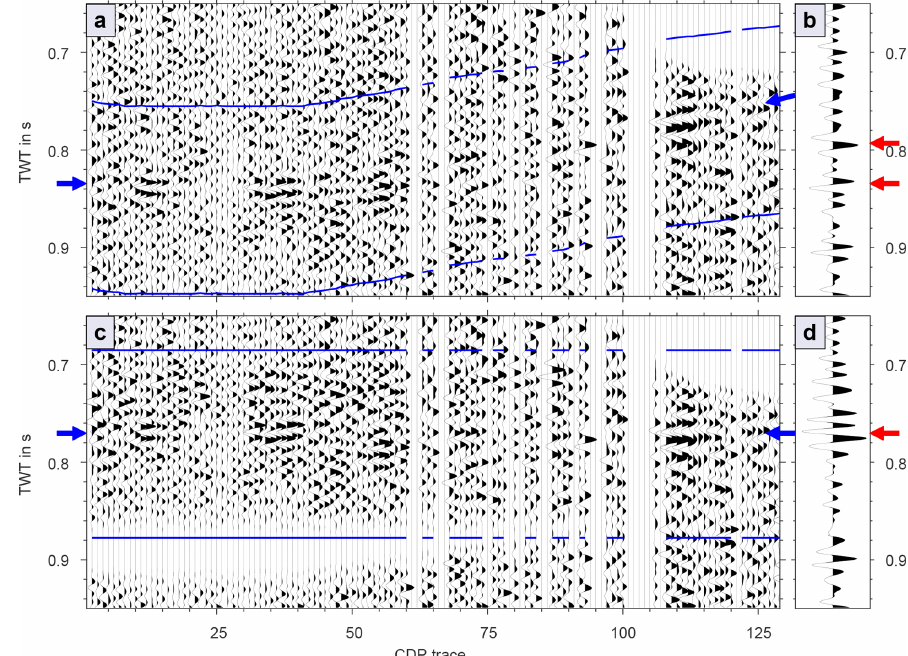
Figure 12. Cross-dip correction of an NMO-corrected reflection in CDP 926 of the Burträsk data. In the uncorrected CDP gather (a) , the reflection is approximately flat in the first traces and inclined in the later traces (correction window marked with blue lines). Consequently, the stack of this gather (b) features two weak maxima (red arrows). After cross-dip correction, the reflection gets flattened (c) and the weak maxima in the stack merge to one stronger maximum (d) . Note, however, that the reflections are very difficult to observe in most other CDP gathers and that the cross-dip analysis has therefore been carried out on constant cross-dip stack